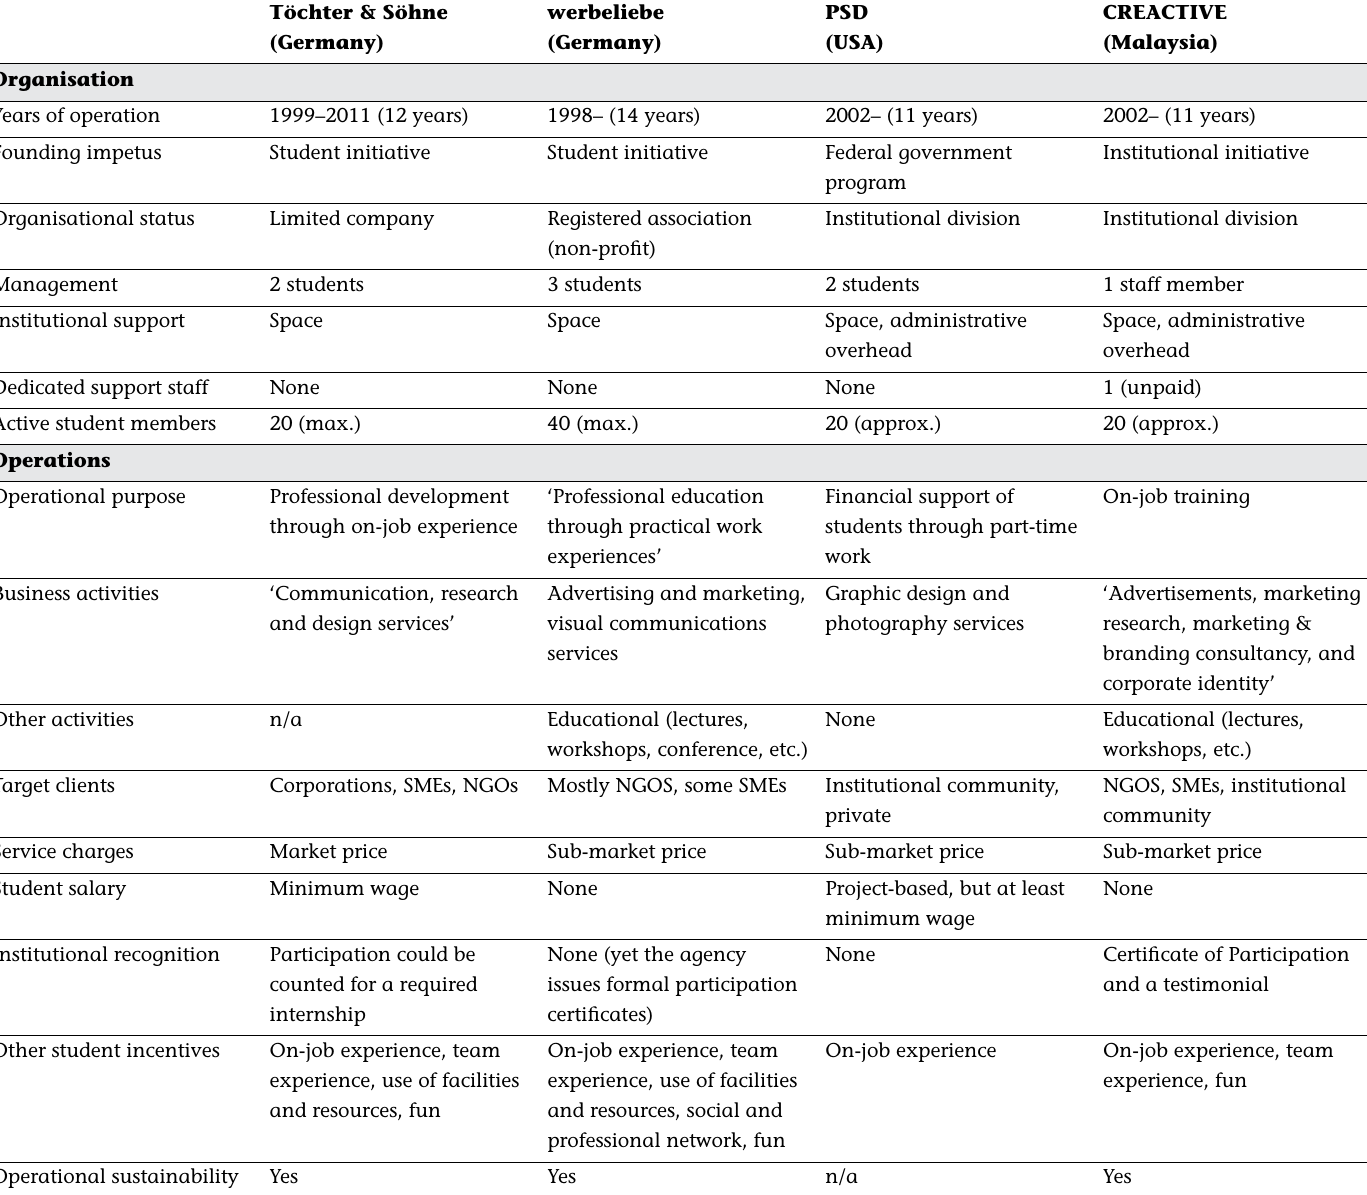
Table 1: Comparison of the four agencies’